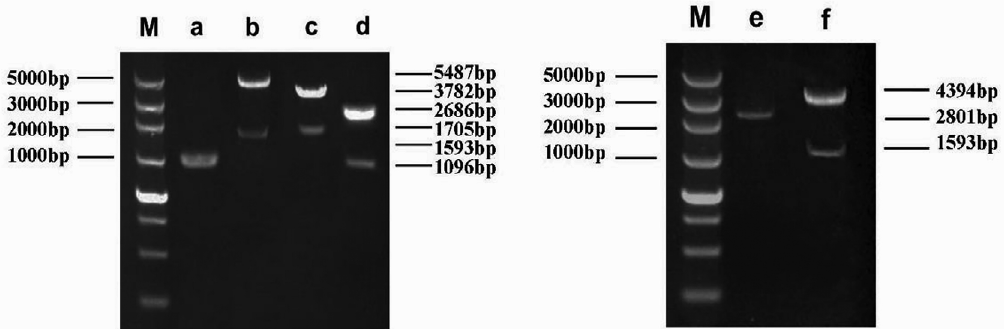
Figure 2- Identification of the clpP deletion strains and clpP complement strains. M: DNA marker; a) fragment of the clpP gene; b) PCR product of pUC18-∆clpP-ermB-clpP; c) PCR product of pUC18-∆clpP-ermB; d) PCR product of the pUC18-∆clpP; e) fragment of ∆clpP- ermB; f) fragment of